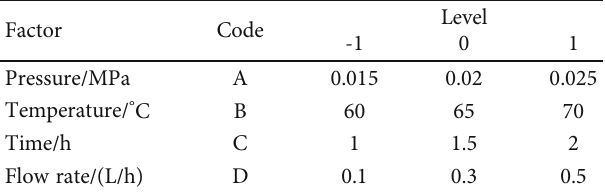
Table 2: The factor levels and coding values of the Box-Behnken design of LPSS drying.